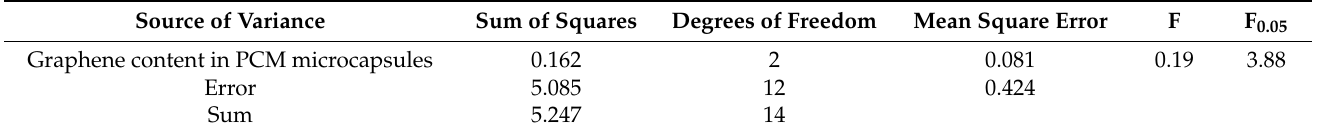
Table 13. Variance analysis of the bending strain energy in the performed freeze–thaw splitting test. Source of Variance Sum of Squares Degrees of Freedom Graphene content in PCM microcapsules